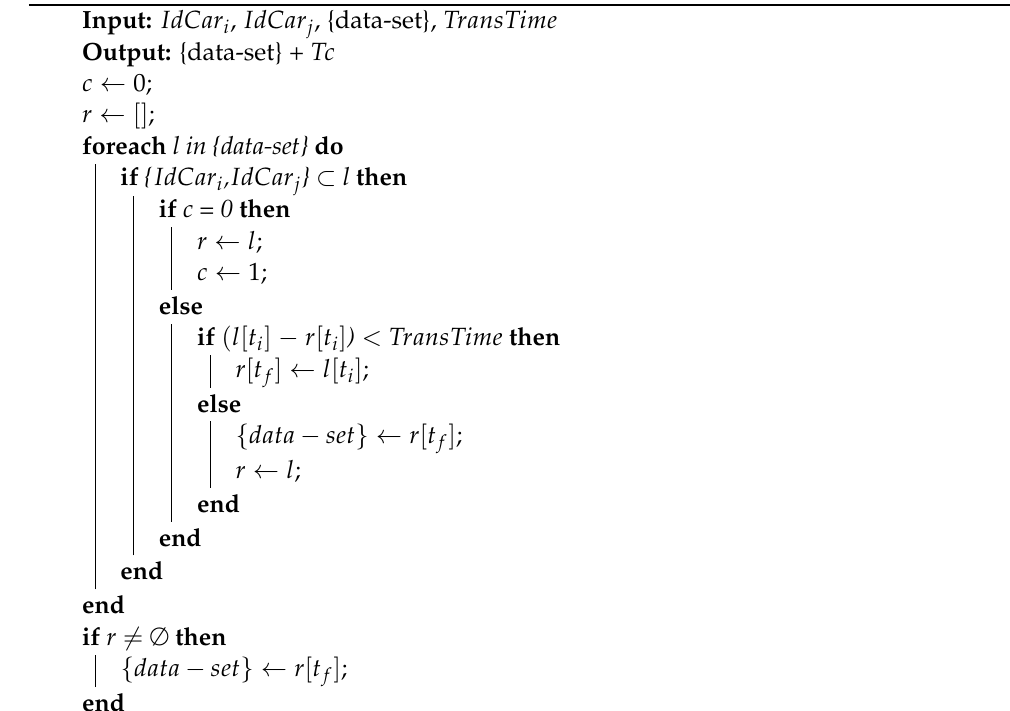
Algorithm 1: Computation of the link